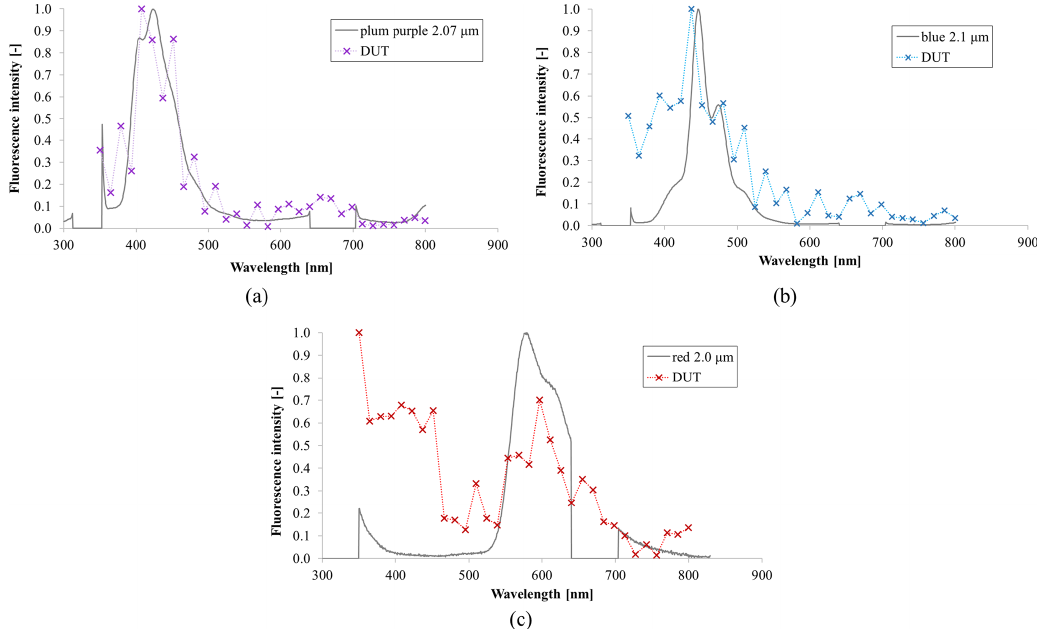
Figure 8. Comparison of the Rapid-E fluorescence measurements (DUT) with the reference measurements from Könemann et al. (2019) for (a) plum purple PSL particles with expected peak at 422nm, (b) blue PSL particles with expected peak at 447nm, and (c) red PSL particles with expected peak at 582nm. All measurements are scaled to a maximum value of 1.